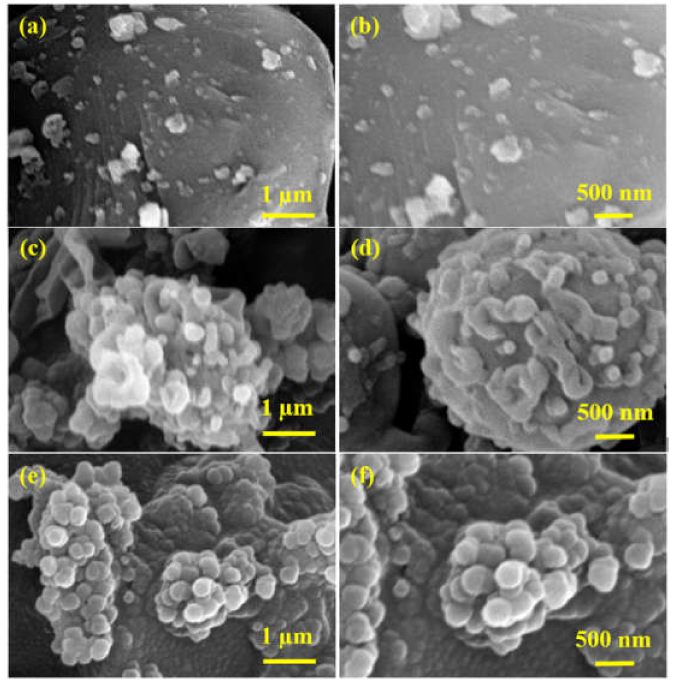
Figure 5. SEM micrographs of ( a , b ) M-50, ( c , d ) M-100 and ( e , f ) M-200 membranes.